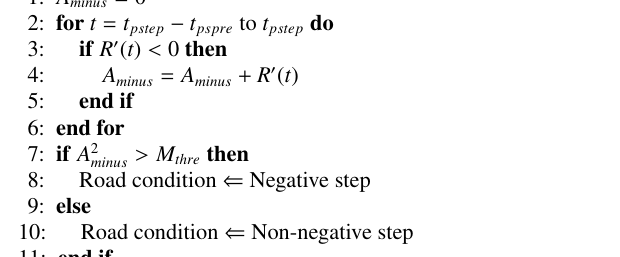
Figure 2: Four road conditions